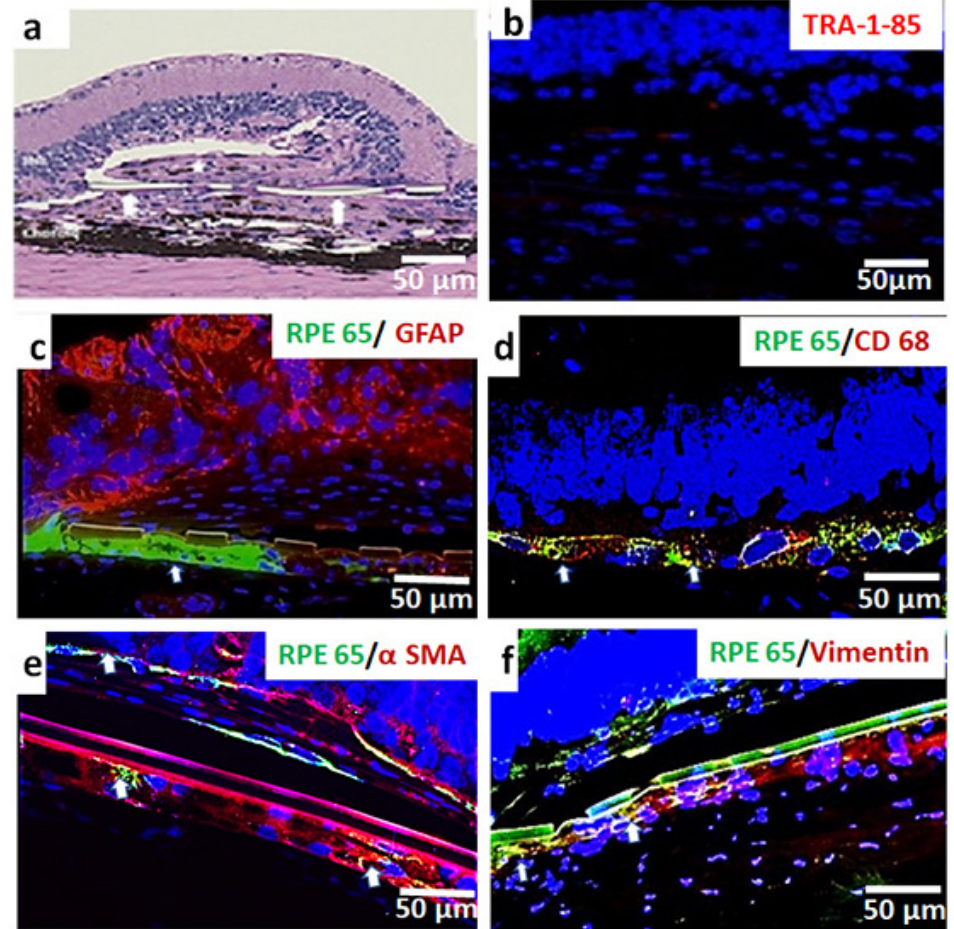
Figure 4. Representative HE and immunostaining images of immunodeficient RCS rat retinas implanted with iPSC-RPE monolayer assessed at 11 months post-implantation. Presence of fibrosis, immunoreactivity, and epithelial–mesenchymal transition (EMT) was assessed. ( a ) Retina with no surviving iPSC-RPE showing signs of inflammation and peri-membrane fibrosis indicated by white asterisk. ( b ) Absence of TRA-I-85 staining. ( c ) Retinas showing RPE65 expressing iPSC-RPE cells (white arrows) labelled for GFAP (glial cells), ( d ) CD68 (macrophages/microglia), ( e ) expression of classical mesenchymal markers α smooth muscle actin α SMA and vimentin. ( f ) Images in which iPSC-RPE monolayer appears to be present below the parylene membrane are either due to orientation difference in the implant placement or due to the survival of the RPE on the lower side of the parylene